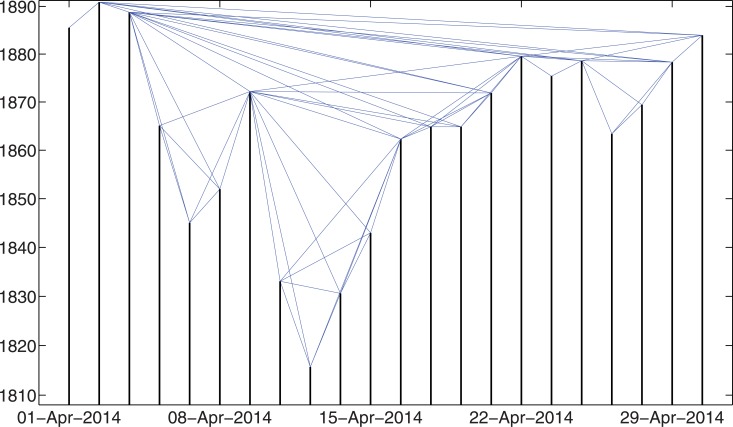
Example of the constructed networks by the visibility algorithm.This example is based on the S&P 500 Index daily close price in April, 2014. Note that the non-trading dates have been removed from the figure.